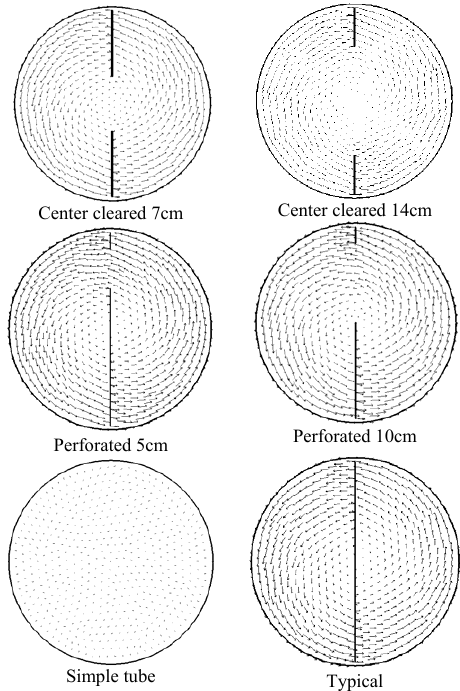
Fig. 7 Velocity vectors at the exit area of the tube geometries